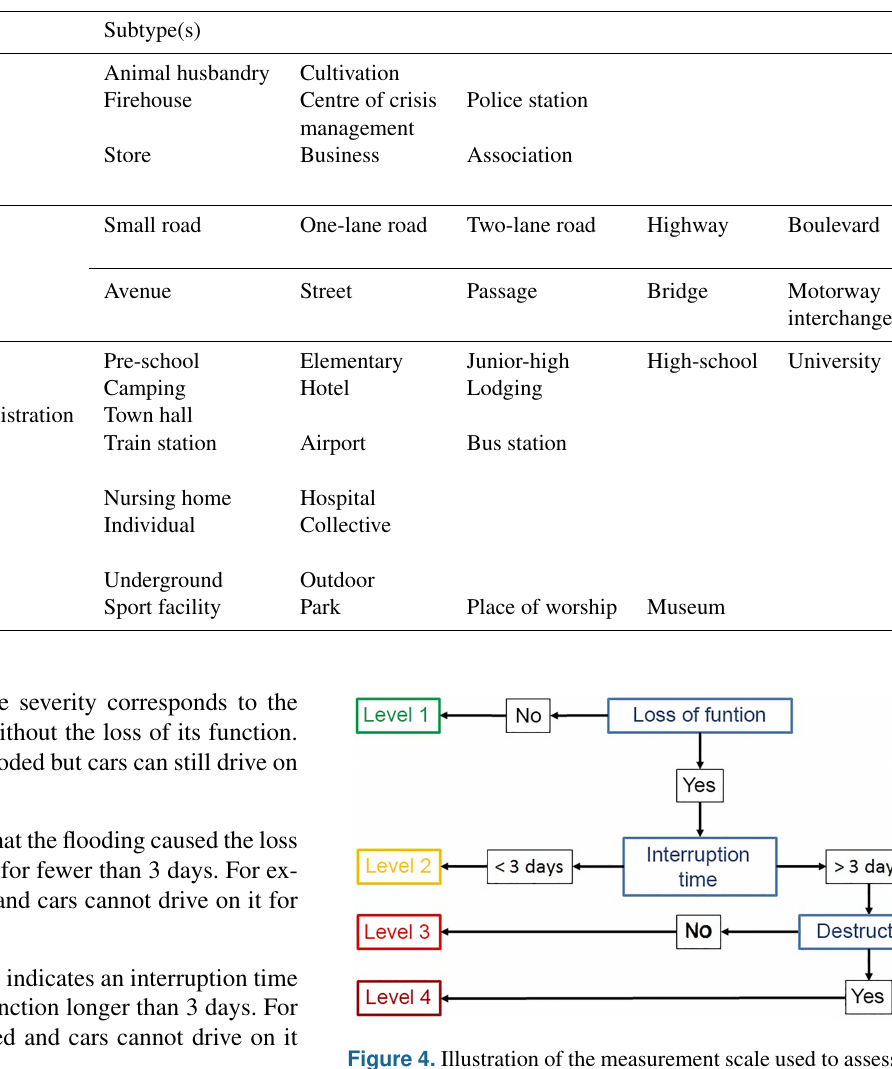
Table 1. Types and subtypes of damaged elements within the DAMAGE feature class.